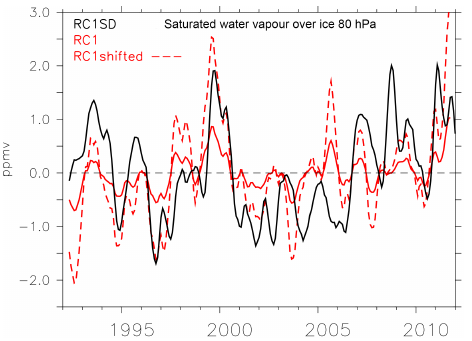
Figure 6. Saturation water vapour anomaly over ice (deseasonal- ized, 6-month running mean) calculated from the respective cold point temperatures (10 ◦ S–10 ◦ N) of RC1SD and RC1 simulations. RC1 shifted: mean cold point temperature of RC1 is shifted to RC1SD mean cold point temperature. The mean cold point tem- peratures are RC1SD: 192.1K and RC1: 186.0K (RC1 shifted: